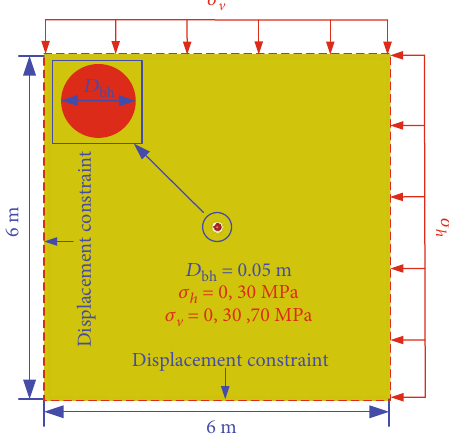
Figure 7: Blasting model without empty